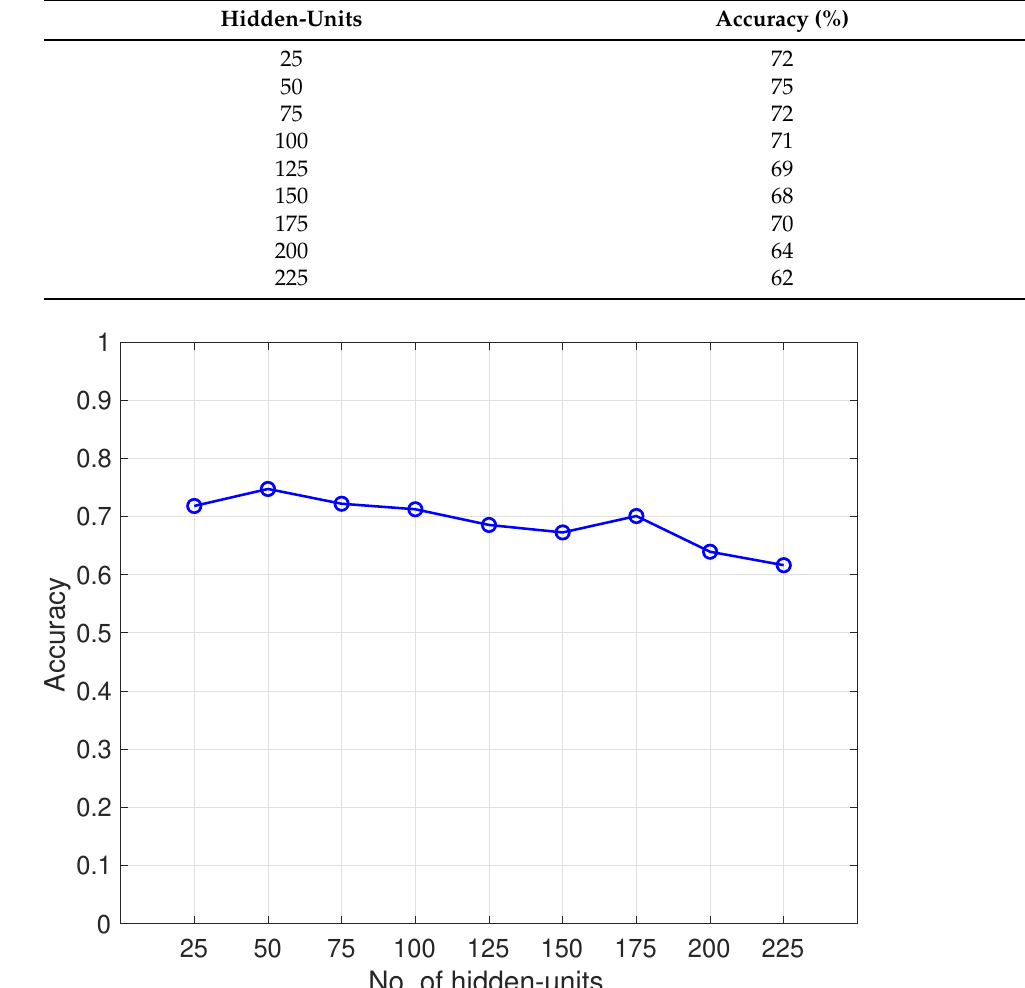
Table 2. Accuracy versus number of LSTM hidden-units.